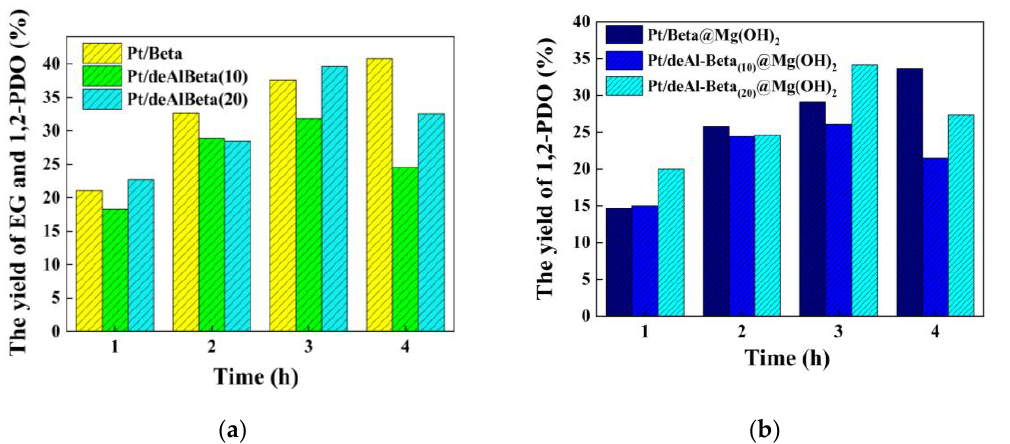
Figure 1. The effect of beta zeolite dealumination time on glucose hydrogenolysis into ( a ) 1,2-PDO and EG; ( b ) 1,2-PDO. Reaction condition: catalyst (200 mg), Pt loading (3.0 wt%), Mg(OH) 2 loading (7.5 wt%), glucose (11.25 mg/mL, 10 mL) and H 2 (initial 6 MPa) at 200 ℃ for 3 h.